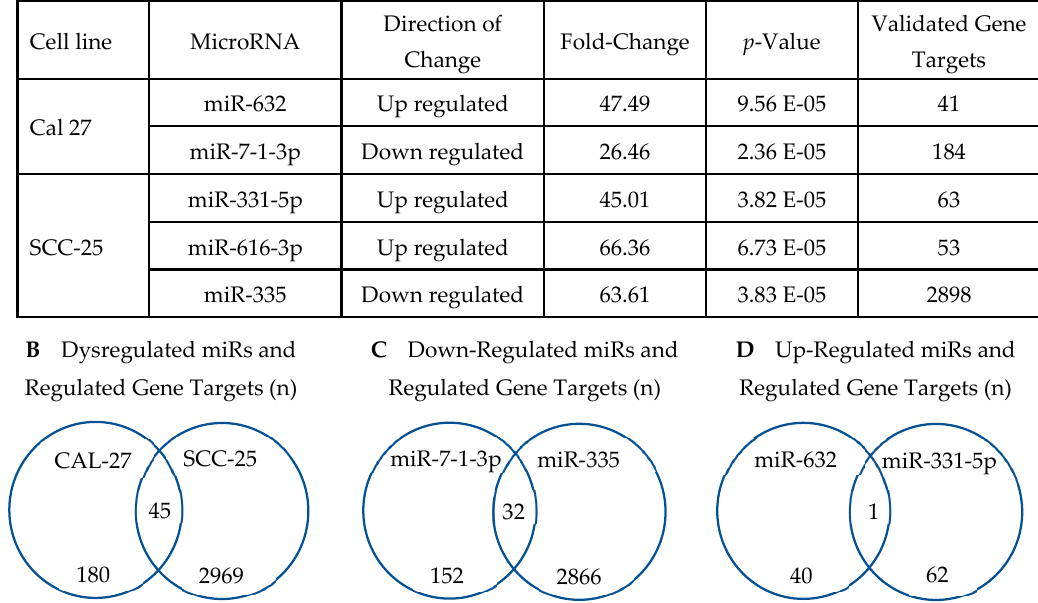
pathway (Table 4) is Steroid biosynthesis ( p -value = 7.72E-06, FDR = 2.2E-03, 13 genes), followed by MAPK signaling pathway ( p -value = 3.89E-05, FDR = 5.52E-03, 65 genes), and Signaling pathways regulating pluripotency of stem cells ( p -value = 6.80E-05, FDR = 6.43E-03, 41 genes). Additional significantly altered pathways linked to down-regulated miRs include Estrogen, PI3K-AKT, RAS, and Chemokine signaling (Table